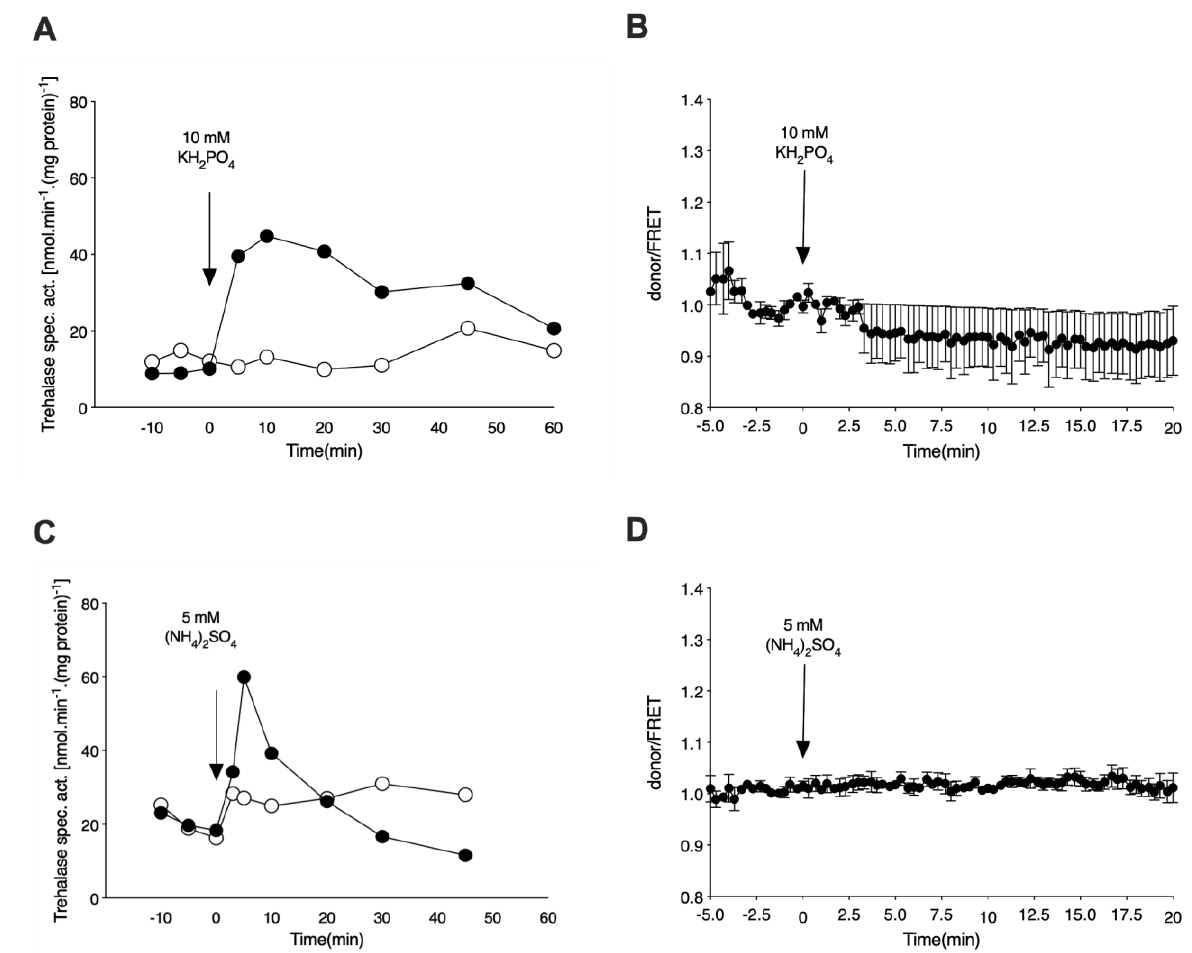
FIGURE 3: Phosphate and sulfate activate PKA in a transceptor-dependent, cAMP-independent manner. (A) Activation of the PKA target trehalase in phosphate-starved cells of the wild type strain after addition of 10 mM KH 2 PO 4 . Strains: wild type (closed circles) and pho84 ∆ (open circles). (B) Donor/FRET levels for cAMP determination in vivo after addition of 10 mM KH 2 PO 4 to phosphate-starved cells of the wild type strain. (C) Activation of the PKA target trehalase in sulfur-starved cells of the wild type strain after addition of 5 mM (NH 4 ) 2 SO 4 . Strains: wild type (closed circles) and sul1 ∆ sul2 ∆ (open circles). (D) Donor/FRET levels for cAMP determination in vivo after addition of 5 mM (NH 4 ) 2 SO 4 to sulfate-starved cells of the wild type